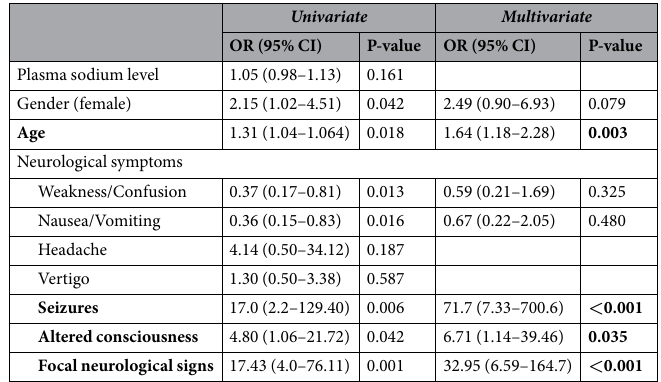
Table 2. Predictors for conducting neuroimaging (cCT/cMRI) using logistic regression analysis. Odds ratios (OR), 95% confidence intervals (CI), and p-values were calculated using logistic regression analysis (backward elimination). Variables were selected a priori based upon theoretical considerations and existing literature. Factors statistically significant at the 10% level in our univariate analysis were then included in our multivariate model. Two-sided p values < 0.05 were considered statistically significant in the multivariate